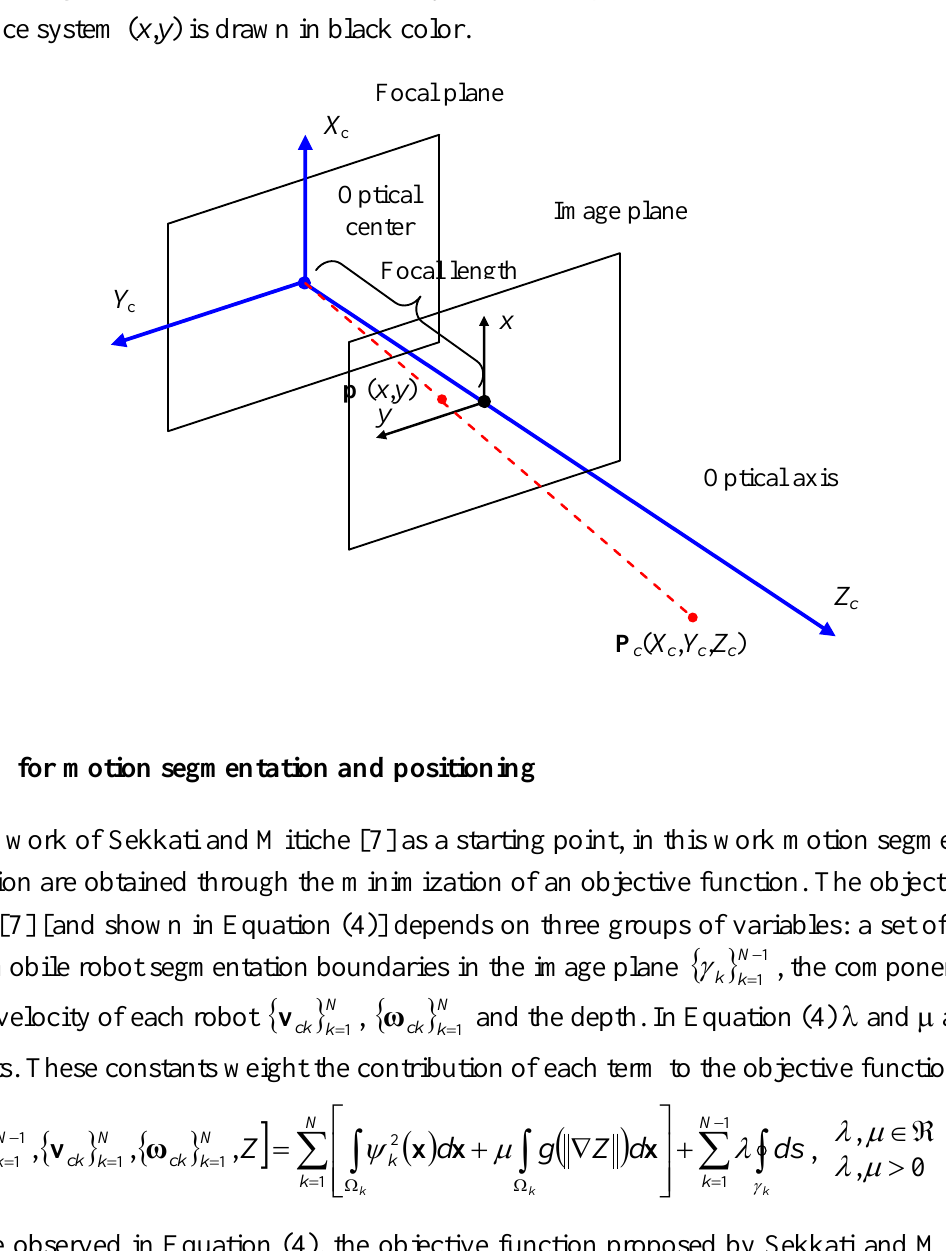
) represented in blue color. The image c